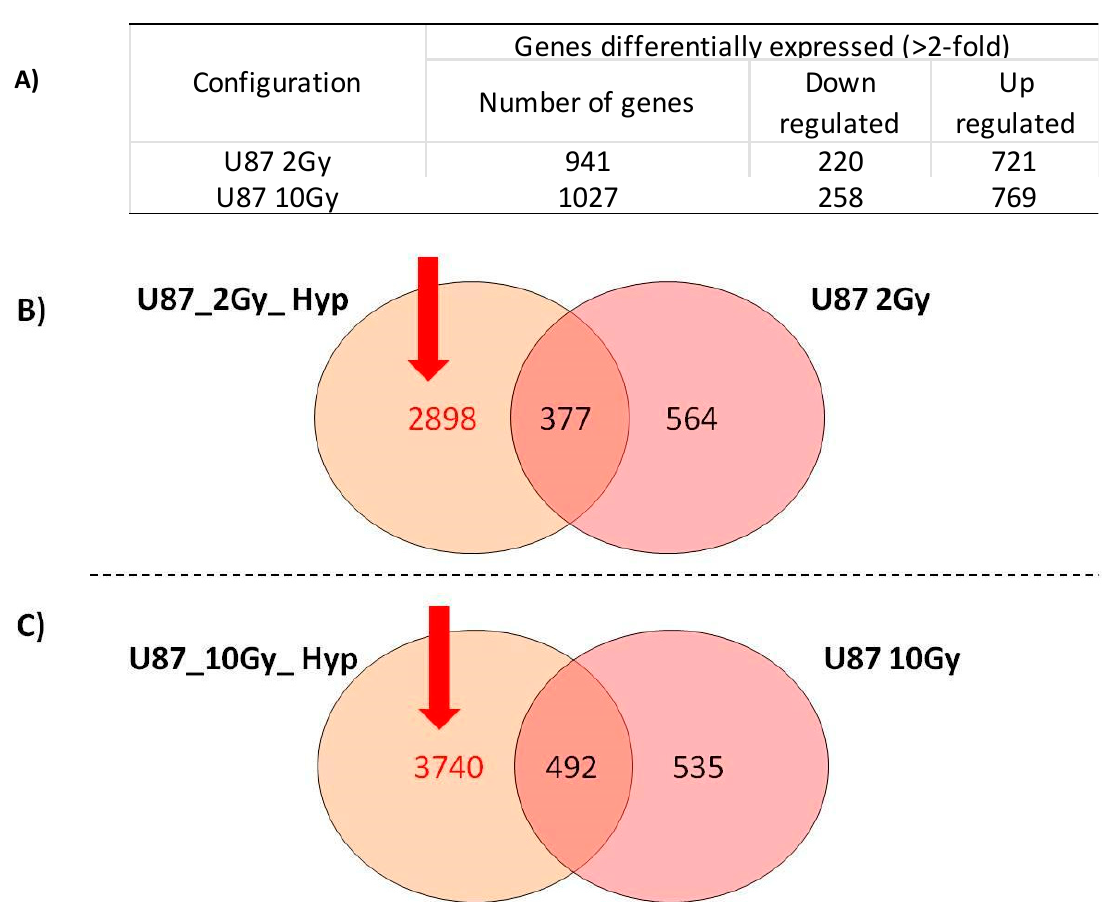
Figure 3. ( A ) Number of genes significantly deregulated by 2-fold in U87 GBM cells exposed to 2 and 10 Gy of PT under normoxia condition. ( B ) Venn diagrams showing the number of unique and shared differentially expressed genes (DEGs) after exposure to 2 Gy of PT under acute hypoxia or normoxia. ( C ) Venn diagrams showing the number of unique and shared differentially expressed genes (DEGs) after exposure to 10 Gy of PT under acute hypoxia or normoxia. In red, the two gene signatures (2898- and 3740) linked to the hypoxia condition are highlighted. Table 5. Pubmatrix analysis of the top 10 statistically relevant pathways ( p values < 0.05) obtained from the 2898-gene signature, upregulated by the combined treatment hypoxia/PT with 2Gy. Glioblastoma Multiforme (GBM); radiotherapy (RT); proton therapy (PT); ionizing radiation (IR).